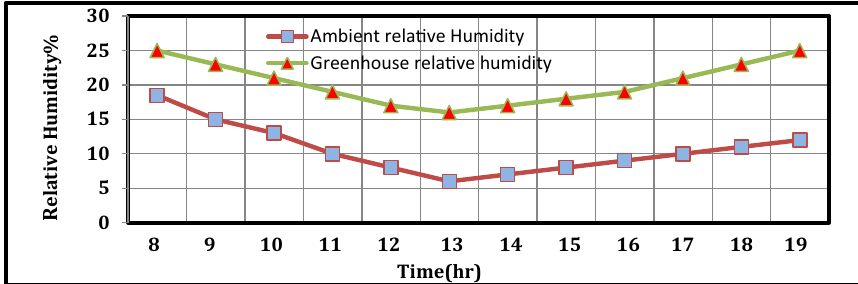
Figure 6: Relative humidity of green - House and ambient conditions during